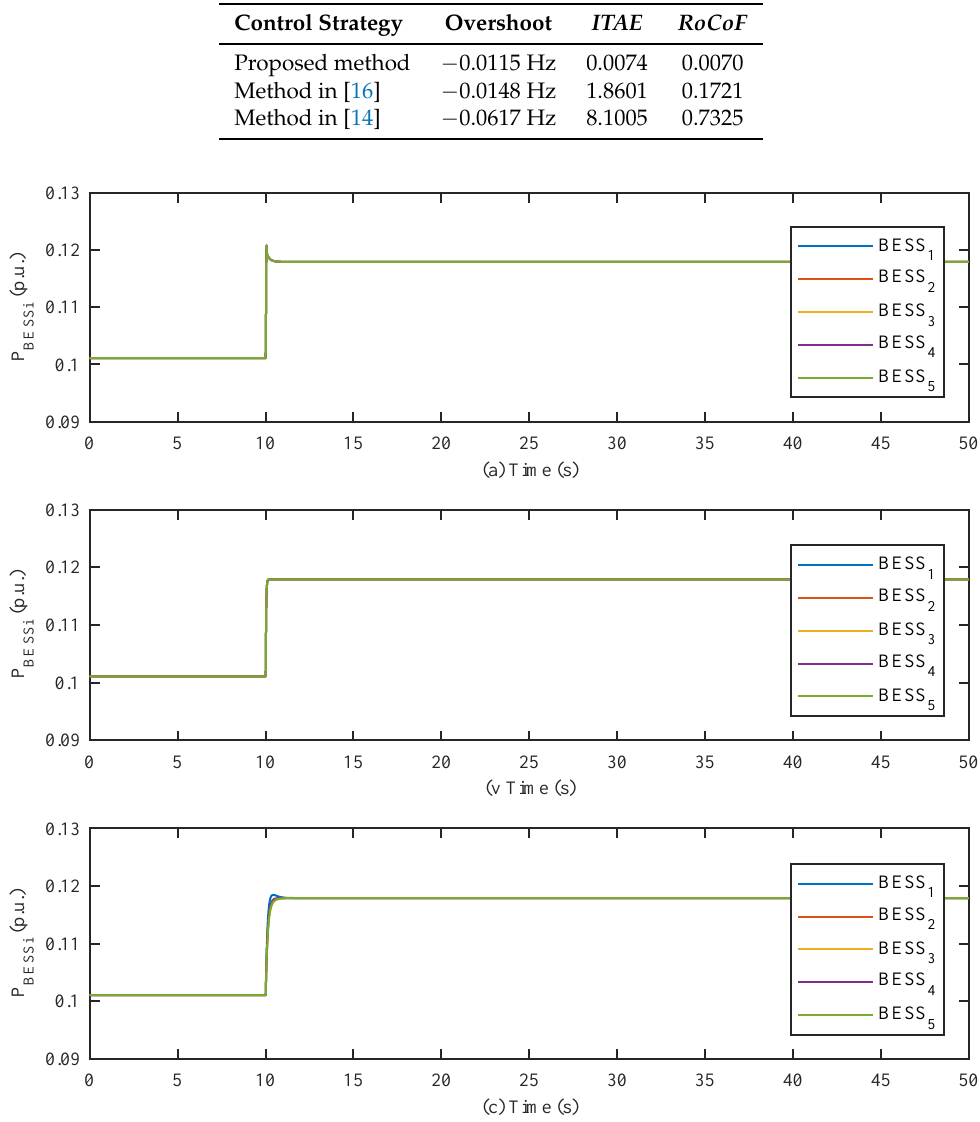
Table 5. Performance comparison with +0.1 p.u. load demand change.